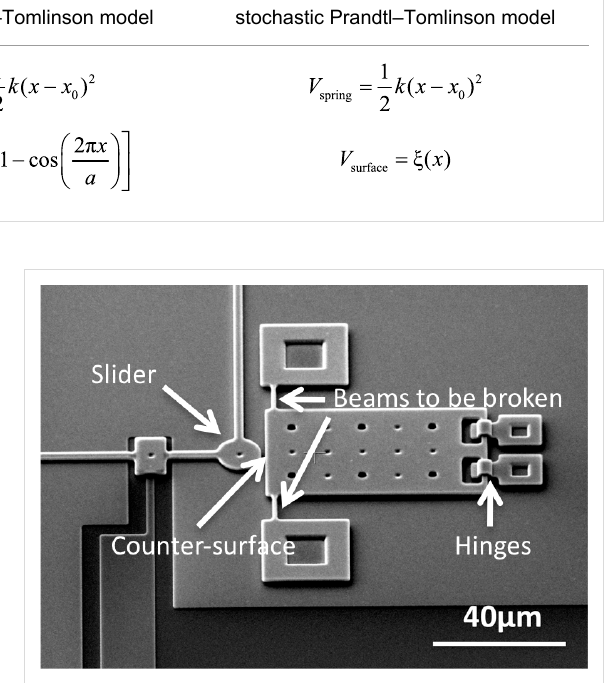
Figure 5: The counter-surface is held by two small beams. After the experiments, the beams can be broken and the counter-surface flipped upright in its hinges with a probe needle, allowing easy access with an AFM cantilever tip. The AFM has been used to measure the surface roughness (Figure 6) on the sidewall at the position where the arrow indicating ‘Counter-surface’ is pointing.